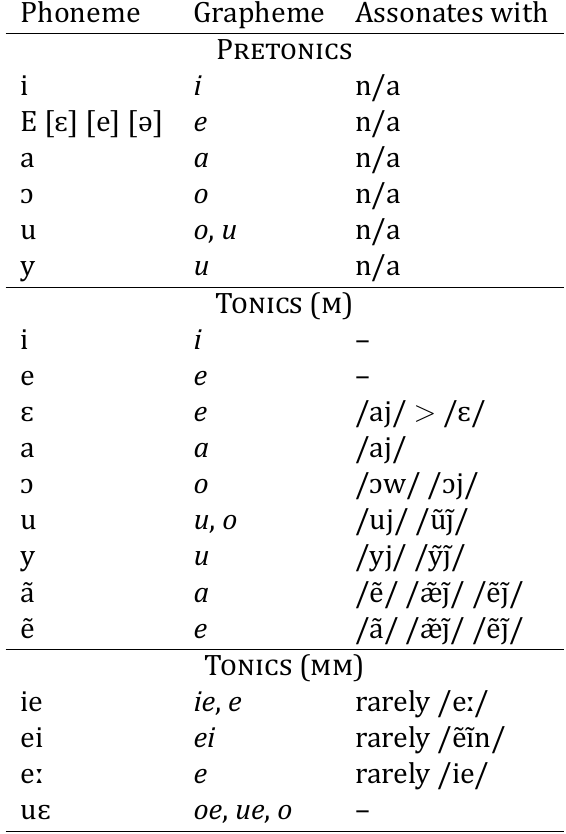
Table 1: Vowel phonemes reconstructed in AlexisRaM and